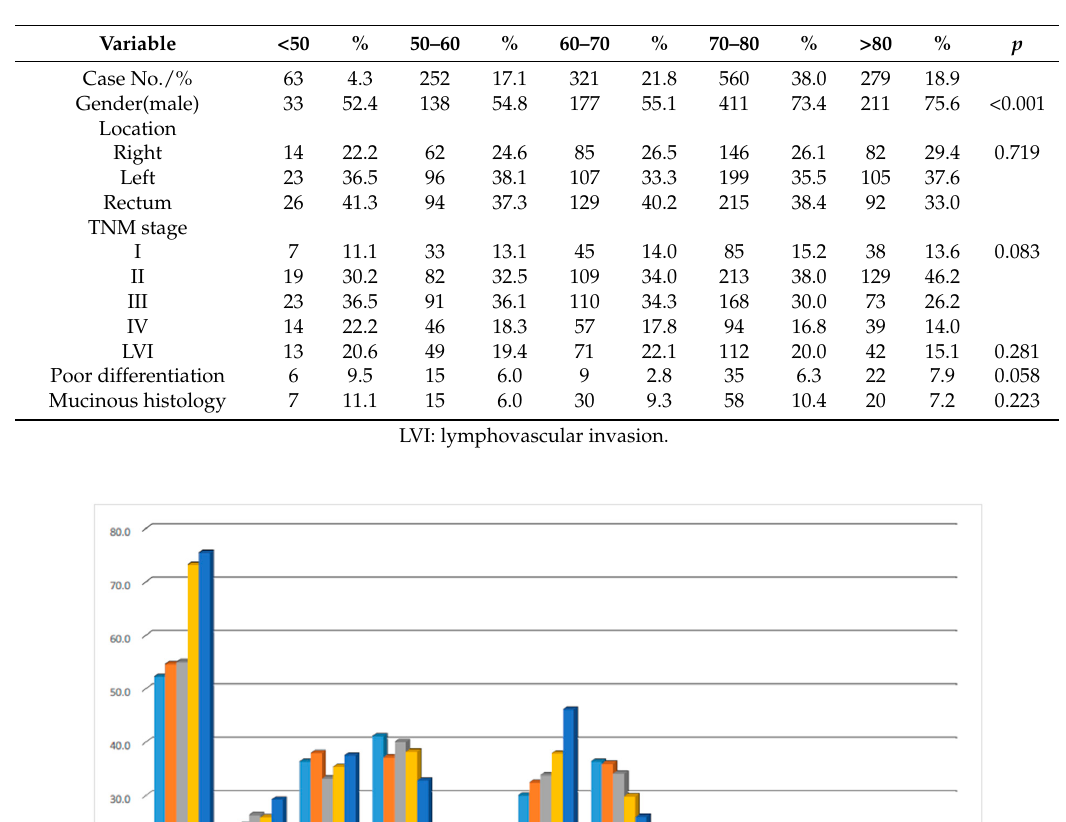
Table 1. Clinicopathological difference between different age groups of CRC (colorectal cancer) patients.